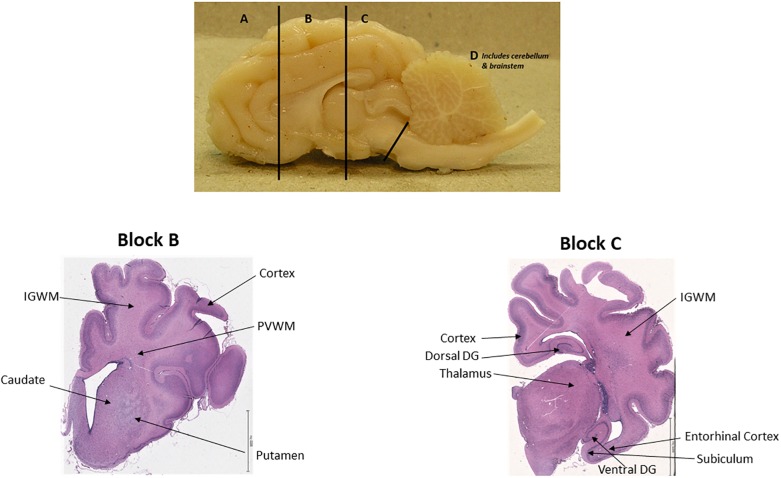
One hemisphere of sheep brain that is cut into four blocks (top); Brain regions of interest in block B and block C. Scale bar = 6.5 mm.